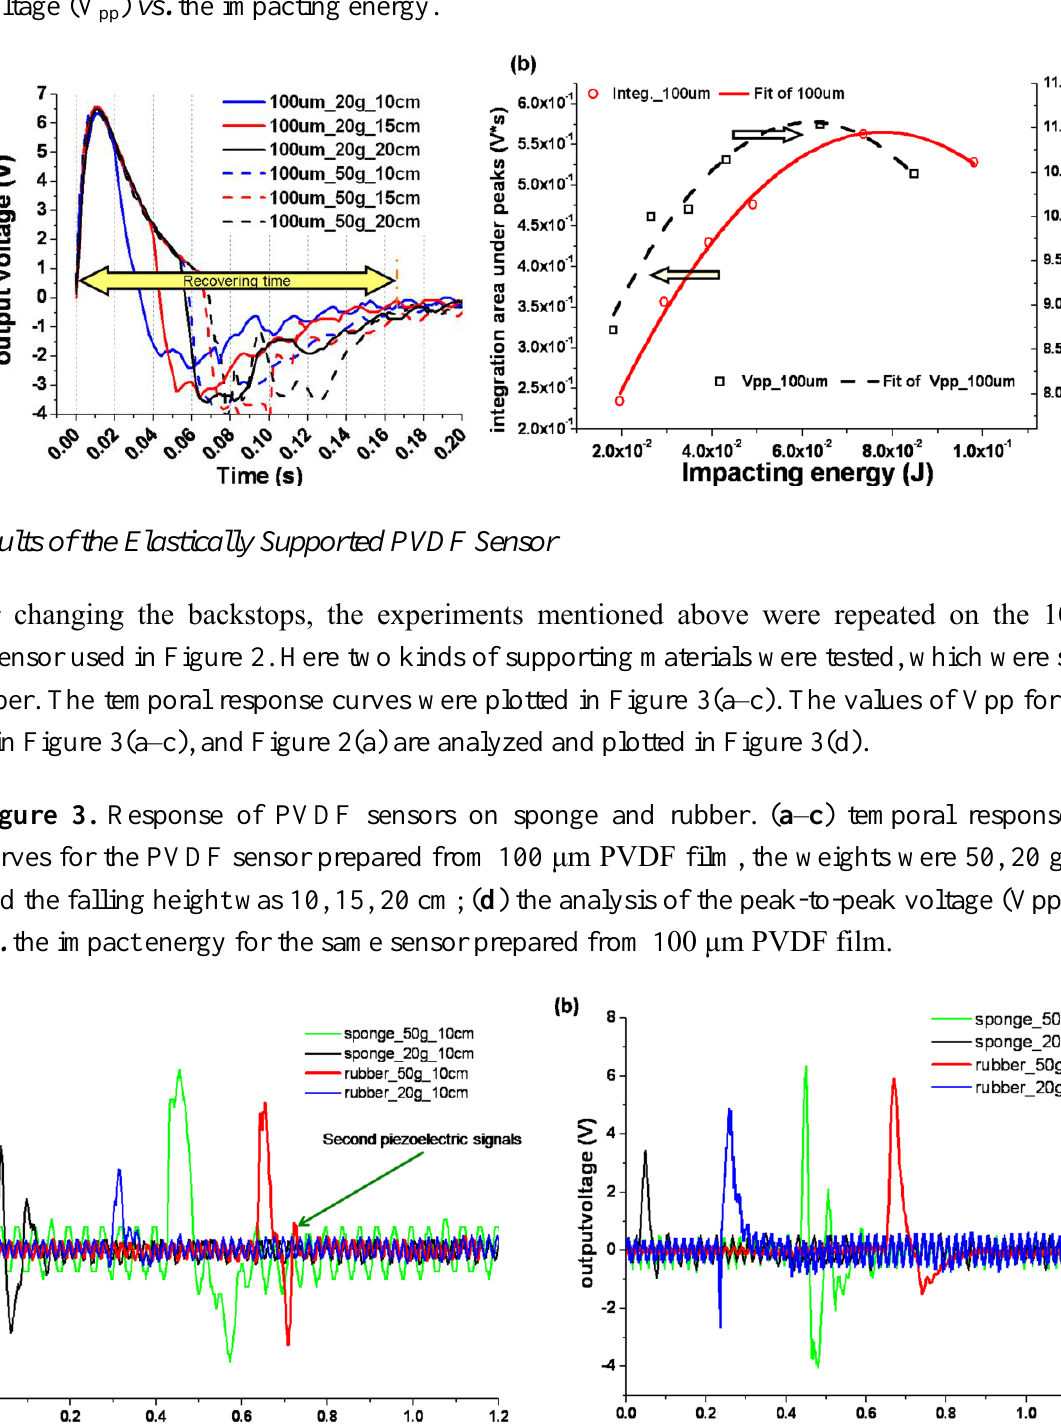
Figure 2. Response of PVDF sensor on the desk: ( a ) temporal response curves for the sensors prepared from 100 μm PVDF film when the weights were 50, 20 g and the falling height was changed from 10 to 20 cm; ( b ) the analysis of peaks’ area and the peak-to-peak voltage (V ) vs. the impacting energy. pp